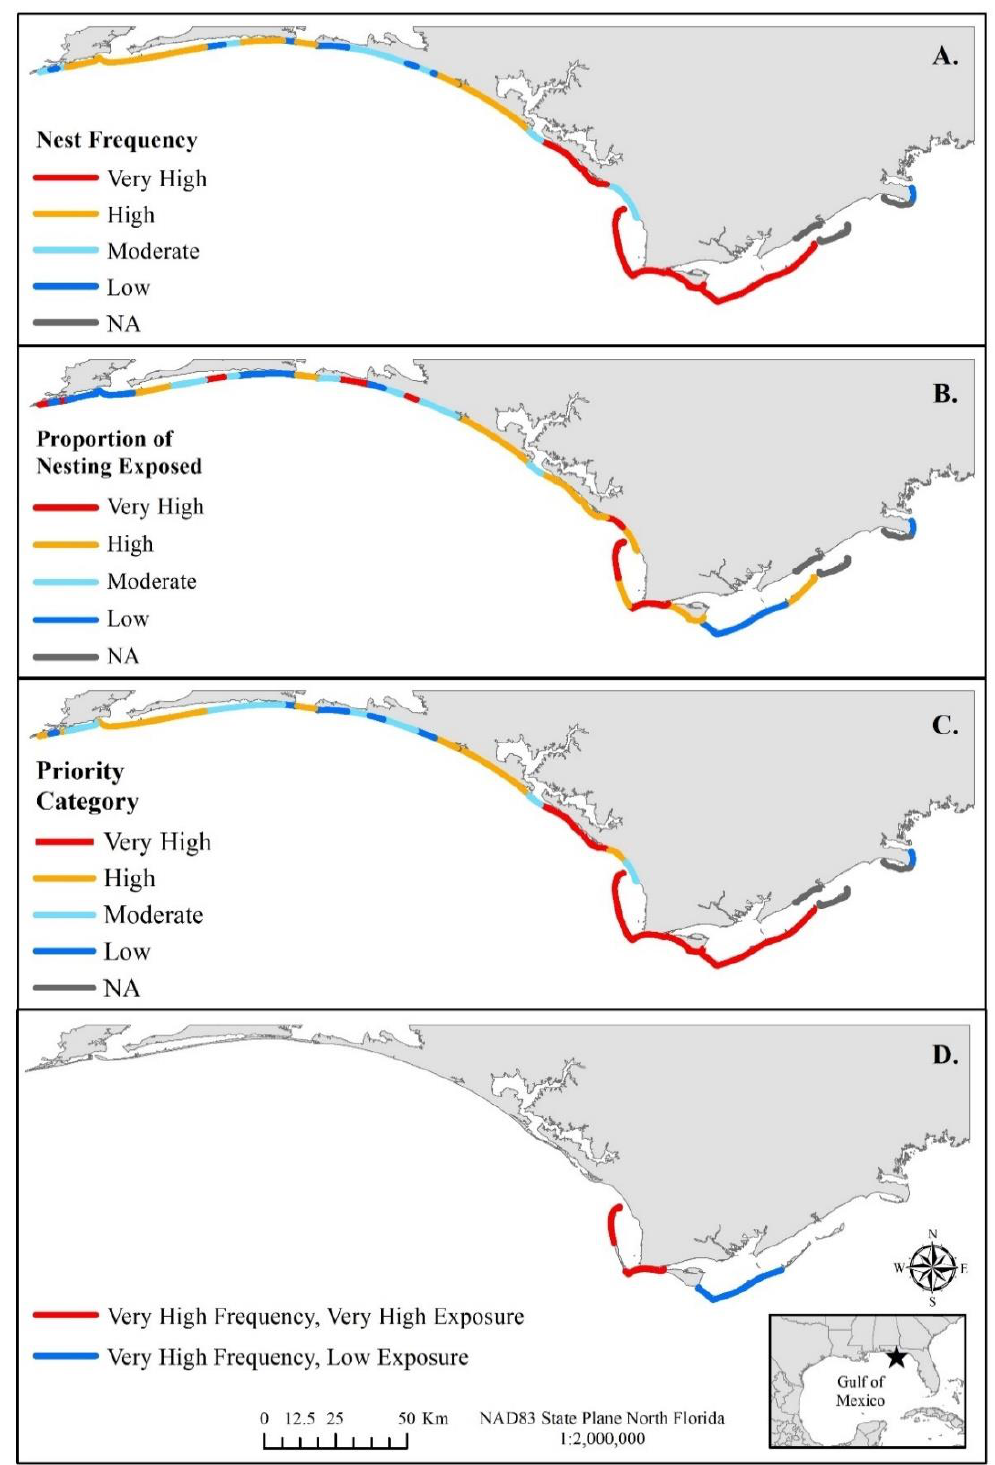
Figure 2. Nesting beach priority category ( C ) based on loggerhead sea turtle nesting frequency ( A ) and the proportion of nest GPS locations exposed to modeled wave wash-over ( B ). Any future consideration for addressing wave exposure impacts would vary with the proportion of nesting exposed to waves. For example, within the nine “very high priority” beaches, three have a “very high” nesting frequency and “very high” wave exposure and two have a “very high” nesting frequency and “low” wave exposure ( D